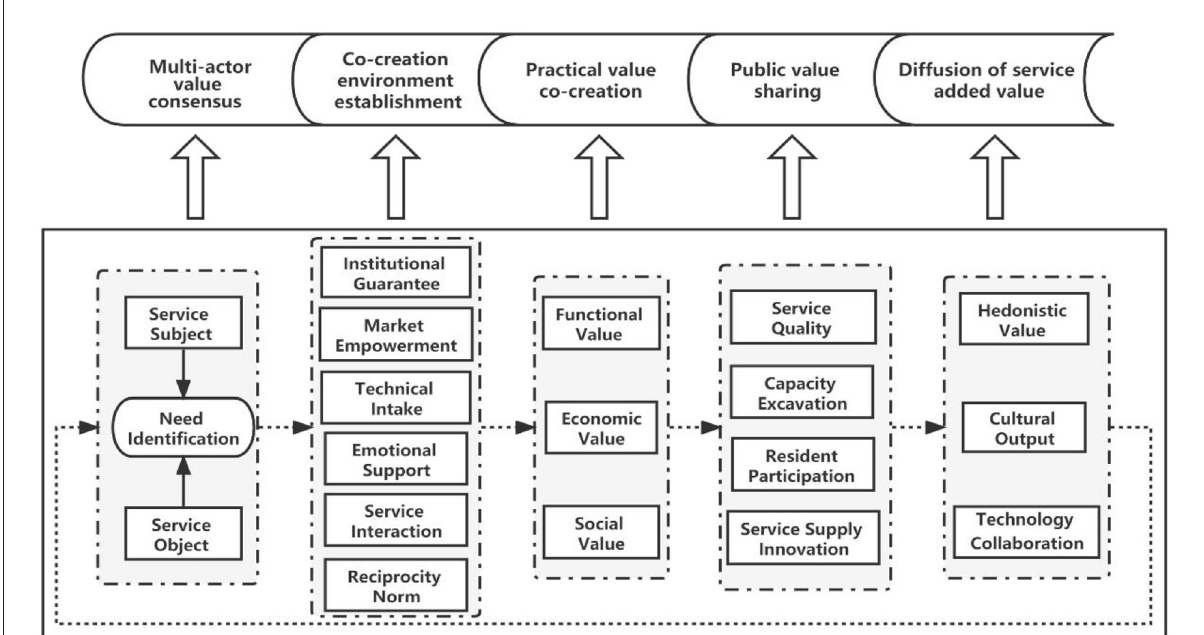
FIGURE2 Practical logic model of SSC value